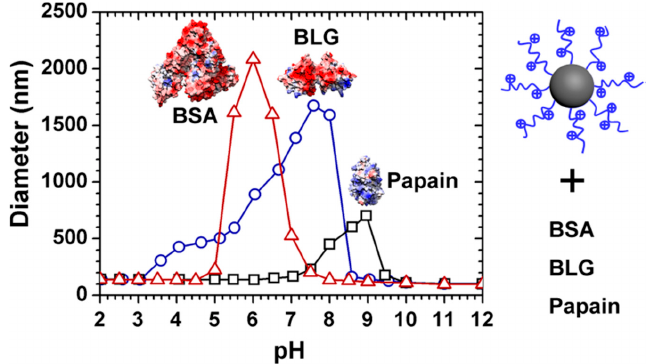
Figure 7. Typical turbidimetric titration curves representing different binding stages of SPB, as well as its selective binding toward different proteins. Figure 7 was taken from the work of [47].